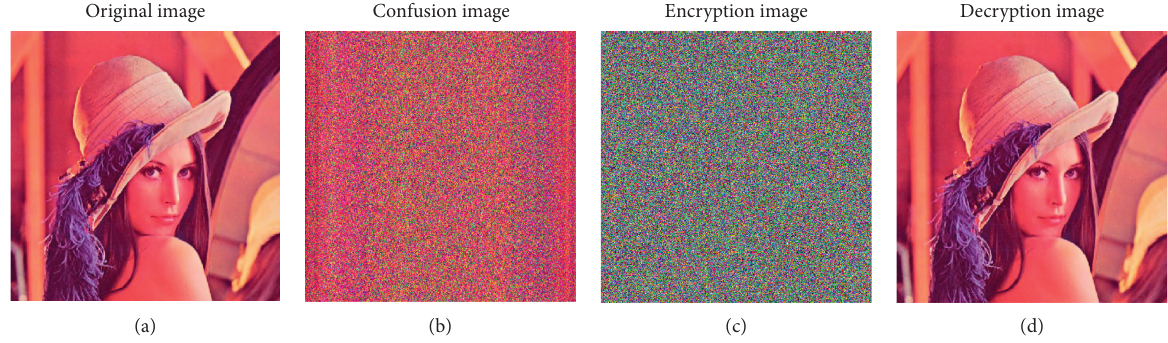
Figure 14: Encryption results. (a) Original image. (b) Confusion image. (c) Encryption image. (d) Decryption image.